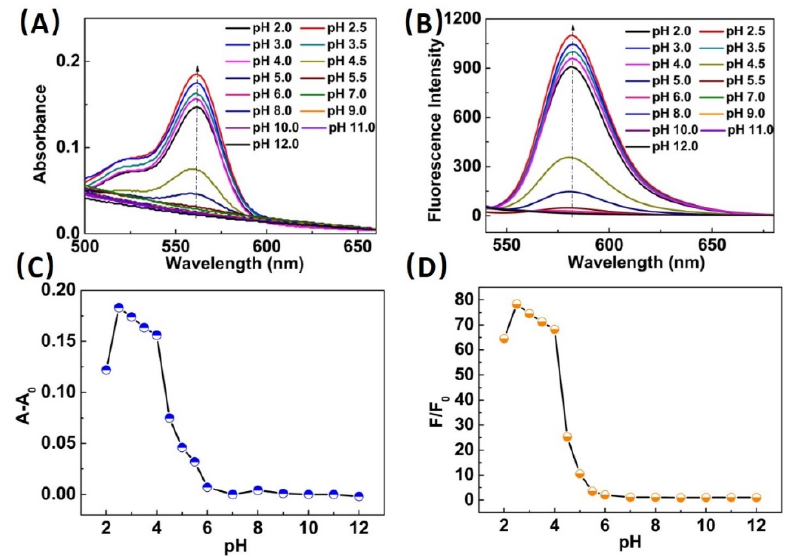
Figure 5. UV–vis absorption ( A ) and fluorescence spectra; ( B ) measured for a rhodamine-functionalized mPEG-b-P(PA-alt-AGERh) copolymer micelles solution (1.5 mg/mL) at different pH; ( C ) The plot of the A–A0 intensity at 560 nm; and ( D ) the plot of the relative fluorescence intensity at 582 nm.